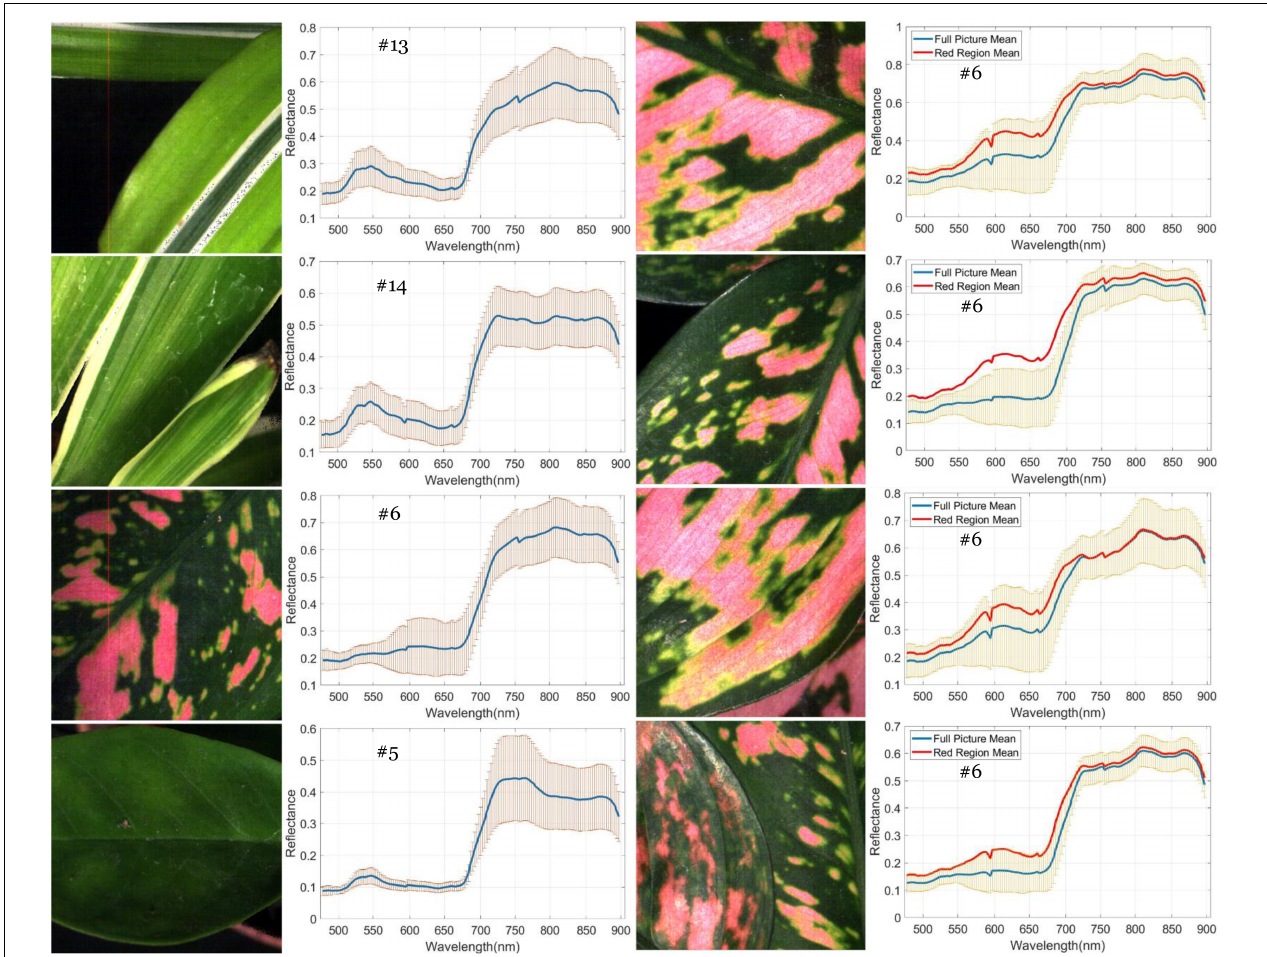
FIGURE 8 | Variation of spectral reflectance in hypercube image of plant leaves. Left: the generalized mean curve and standard deviation ring of the whole leaf pixels for species D.m (#13), C.c (#14), A.an (#6), and Z.z (#5). Right: the difference between the generalized mean curve of the red leaf pixels and that of the global leaf pixels for species A.an. The ring overlapped with the mean curves is the SD of the global leaf